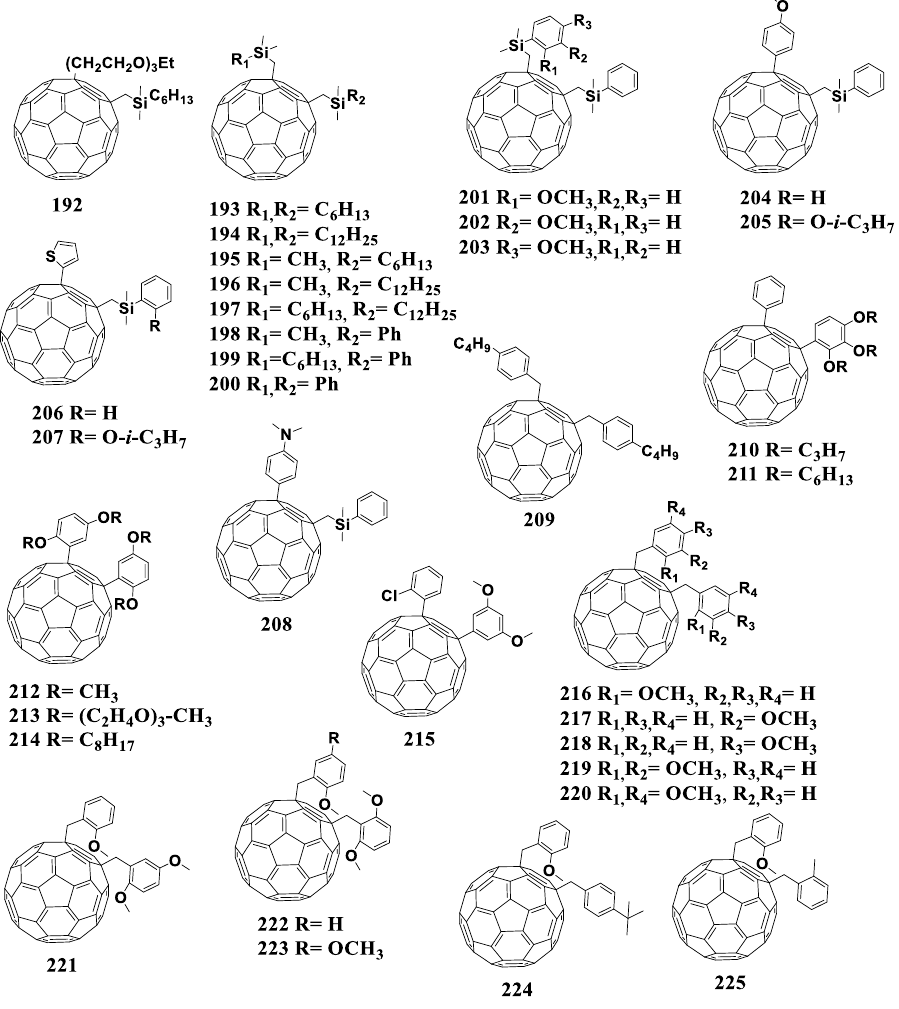
Figure 18. Molecular structures of 1,4-adducts of C 60 fullerene with reduced electron affinity.